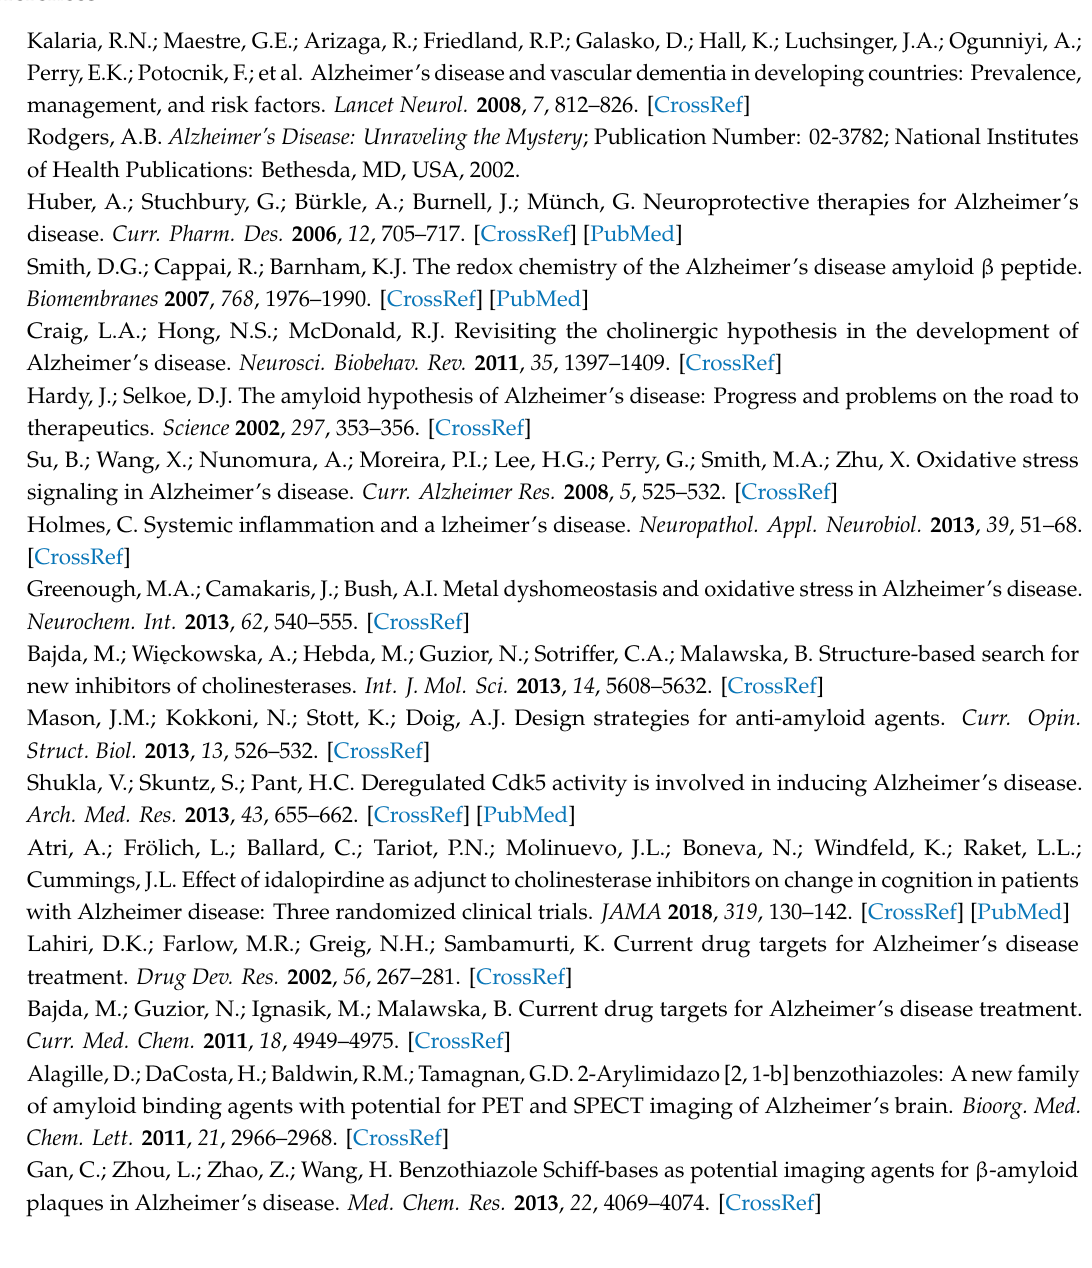
compounds. Figure S8. Purity of compound 2i . Figure S9. 1 H NMR spectra of the compound 2i . Figure S10. 13 C NMR spectra of the compound 2i . Figure S11. HRMS spectra of the compound 2i